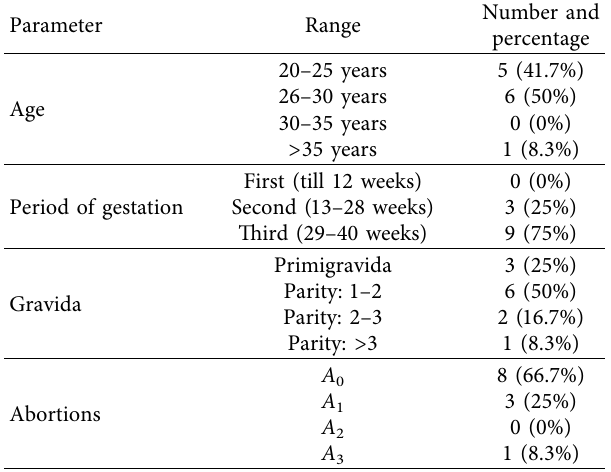
Table 3: Baseline investigations of the pregnant patients with acute pancreatitis.